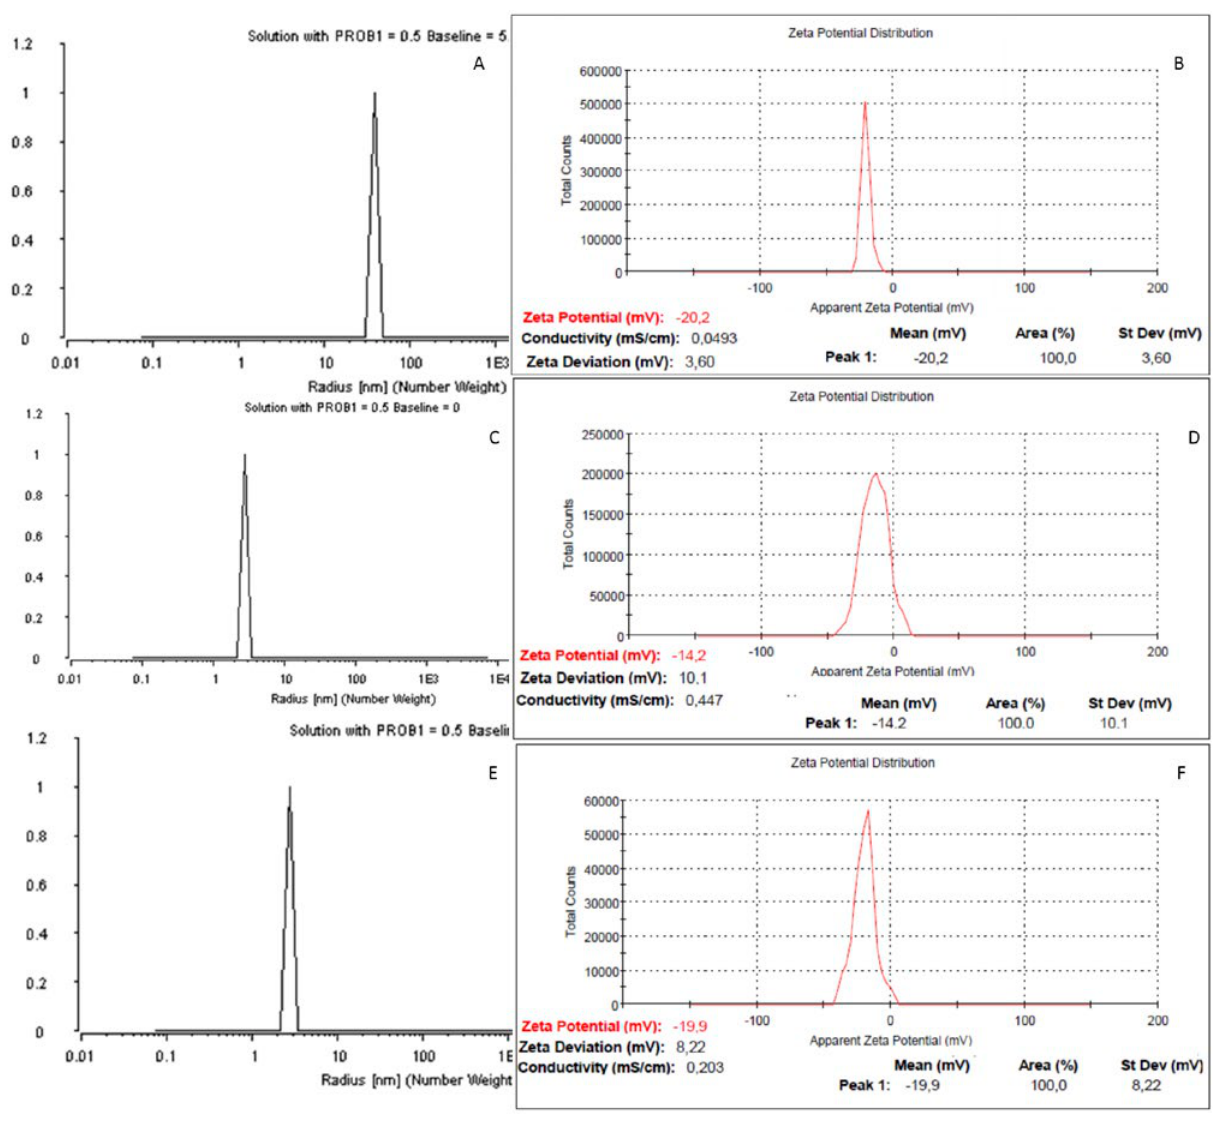
Fig. 6. Size distribution by dynamic light scattering and zeta potential measurement of biyosenthesis silver nanoparticles A, B. LAC-AgNPs; C, D. RAE-AgNPs; E, F.